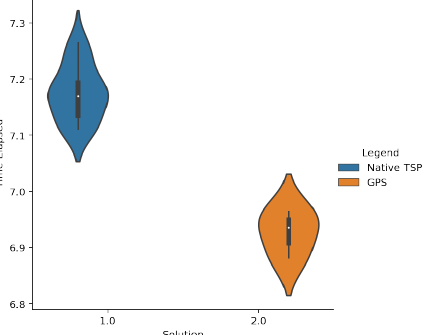
Figure 7. Time comparison for N = 11. For the example of 11 cities, we can observe that the outcomes are quite similar because although there is a mean difference of about 20 s between the results of both simulations, the experience with this problem and other similar ones is that this very small difference does not affect the results on the length of the solution